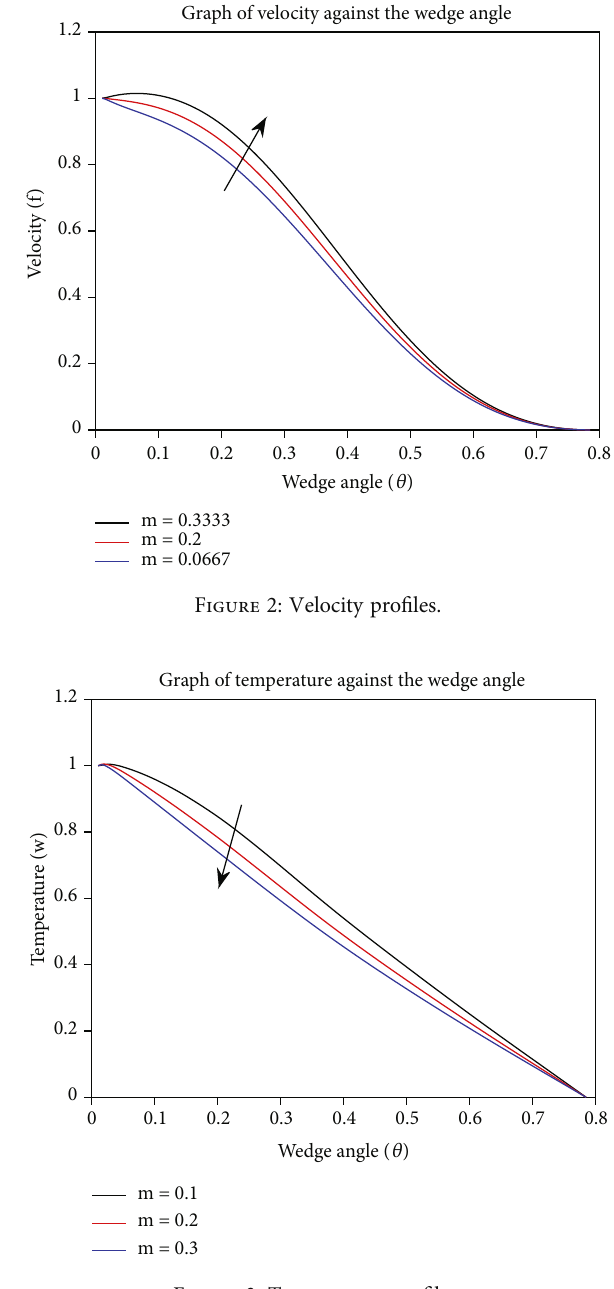
Figure 3: Temperature pro fi